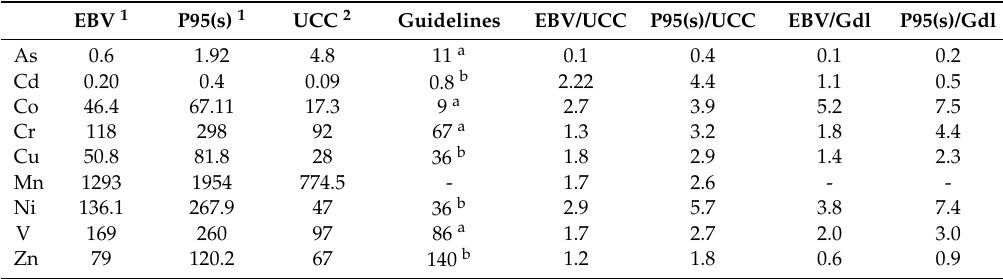
Table 3. Estimated background values, 95 percentiles of Santiago soils (mg · kg − 1 ) and ratios of these values to upper continental crust (UCC) and published guidelines values (Gdl).